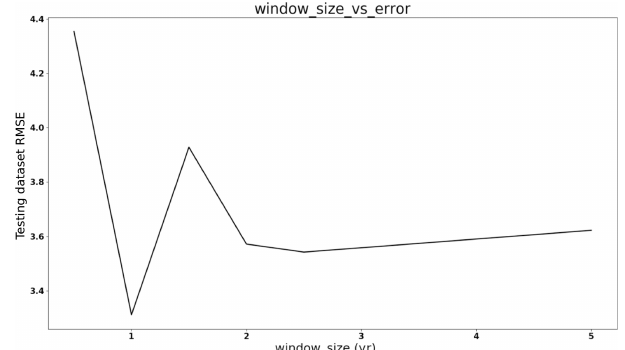
Figure 8. Case Study 1, testing data RMSE vs. window size: the 1-year window size is better than the other window size based on the RMSE